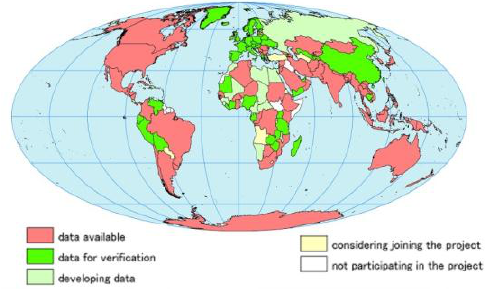
Figure 3: Progress of Data Development Figure 4: Changes in Global Map Version